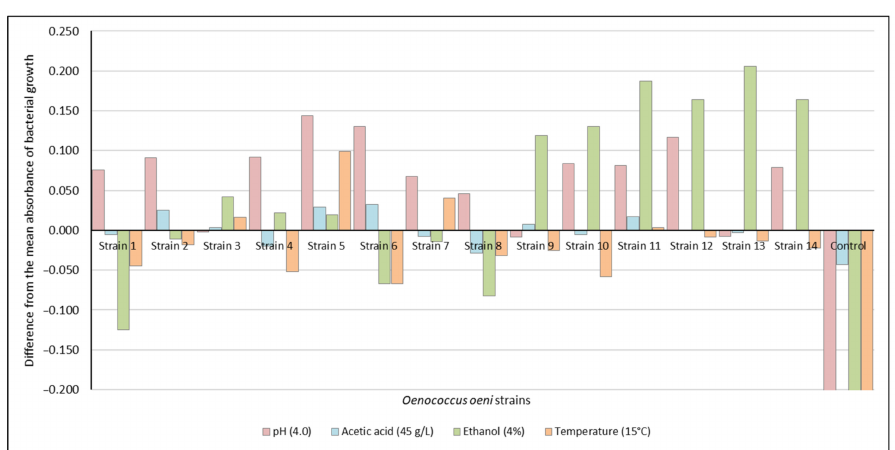
Figure 2. Differences in the mean absorbance of bacterial growth in synthetic media considering the four main DD limiting factors for O. oeni growth (pH 4.0), ethanol (4%), acetic acid (45 g/L), and temperature (15 ◦ C).